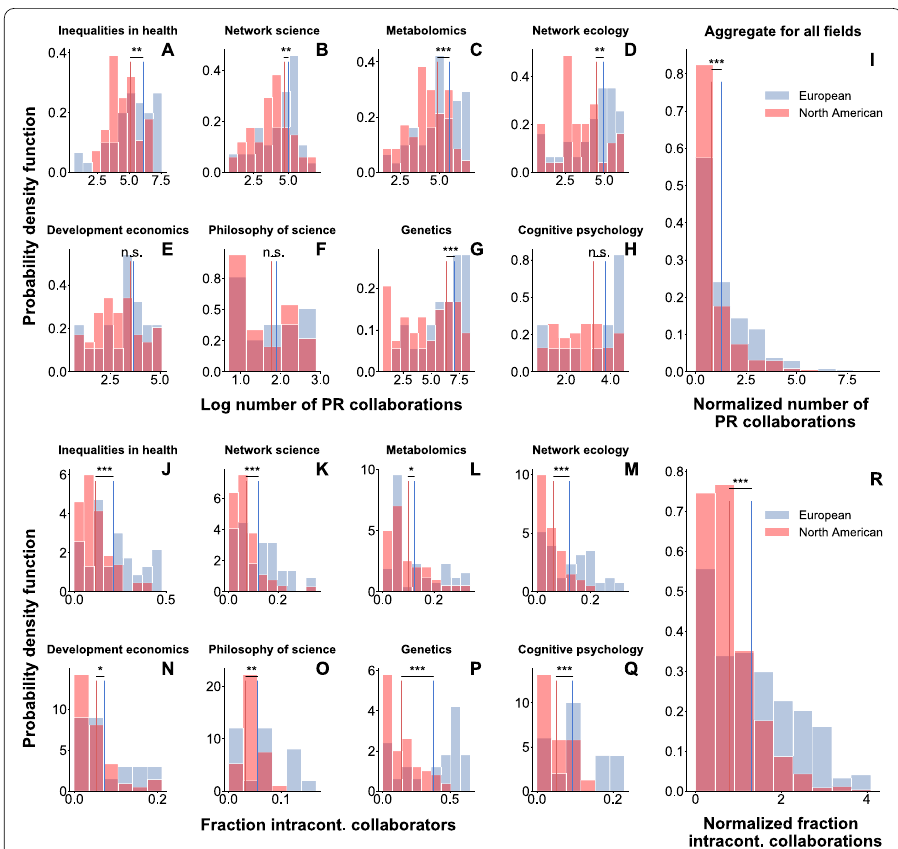
Figure 3 Differences in collaboration patterns between prominent researchers in North America and Europe. ( A )-( H ) Number of prominent researcher (PR) collaborations. We plot the distribution of the logarithm of number collaborations for prominent researchers in North America (red) and Europe (blue). The vertical lines indicate the mean log-number of collaborations for each subset. The significance of the difference between the European and North American means was established by resampling researcher affiliations (one sided test). ( I ) Aggregated distribution for all fields. The log-number of PR collaborations are normalized by the mean in each field so as to make all fields comparable. ( J )-( Q ) Fraction of intracontinental collaborators, defined as the fraction of prominent researchers in the same continent with which a prominent researcher collaborates. We plot the distribution of the fraction of intracontinental collaborators in North America (red) and Europe (blue). The vertical lines indicate the mean fraction of intracontinental collaborators for each subset. The significance of the difference between the European and North American means was established by reshuffling researcher affiliations (one sided test). ( R ) Aggregated distribution for all fields. The fractions of intracontinental collaborations in each field are normalized by the mean of the field so as to make all fields comparable. Stars indicate significant differences (***: 1%, **: 5%, *: 10%, n.s.: not